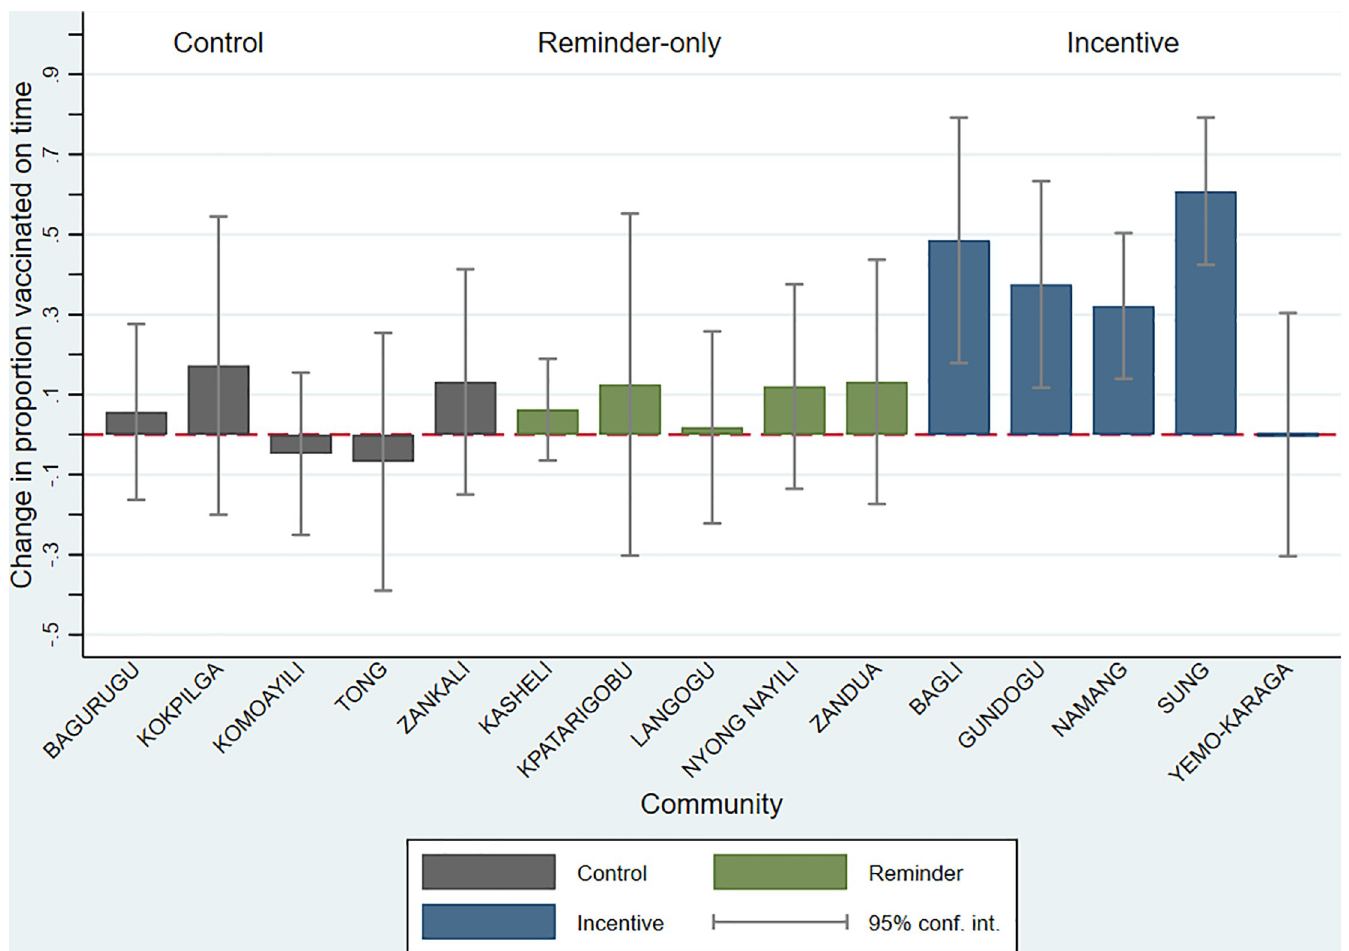
Fig 3. Change in proportion of young infants vaccinated on time pre-intervention and GEVaP intervention period, by community (N = 690). � Timely vaccination defined as first Polio dose and BCG by 14 and 28 days of life (DOL), respectively. Estimates from linear regression models of on-time vaccination regressed on period (pre-intervention or intervention), for each community. Change over time defined as β coefficient for period, with robust variance estimates.